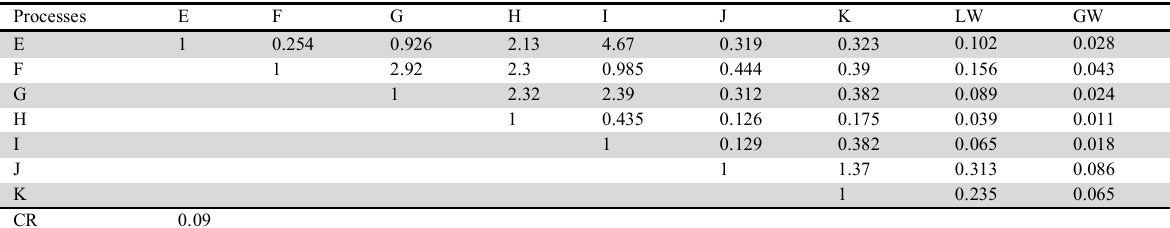
Relative importance normalized local, global weights and consistency ratios of the internal processes perspective indicators.